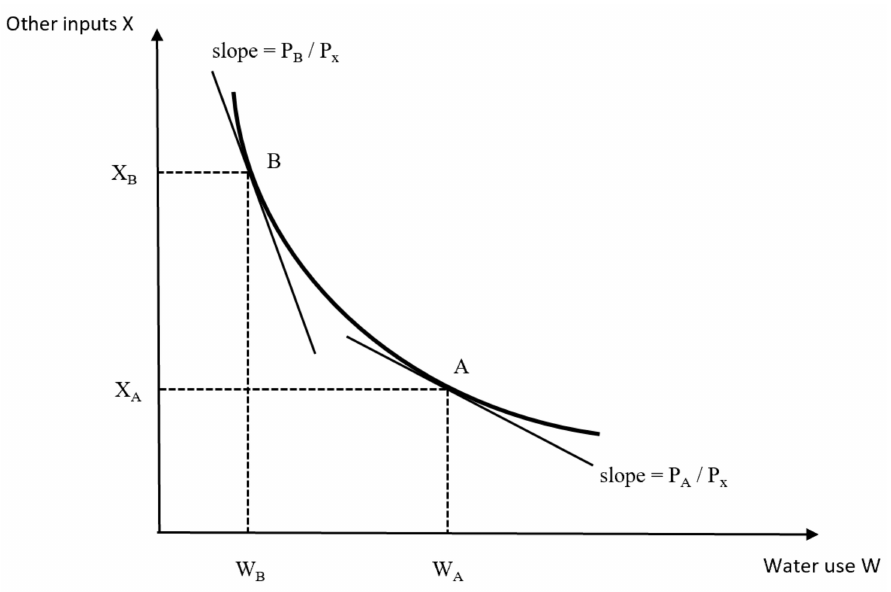
Figure 2. Technical e ffi ciency in use of water and other